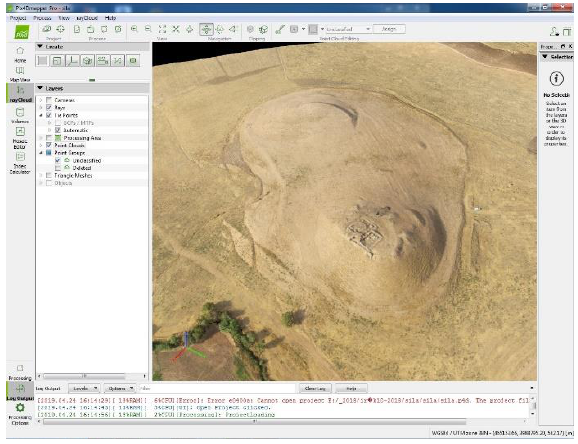
Figure 4. View of 3D model of the Qala Shila archaeologic site,